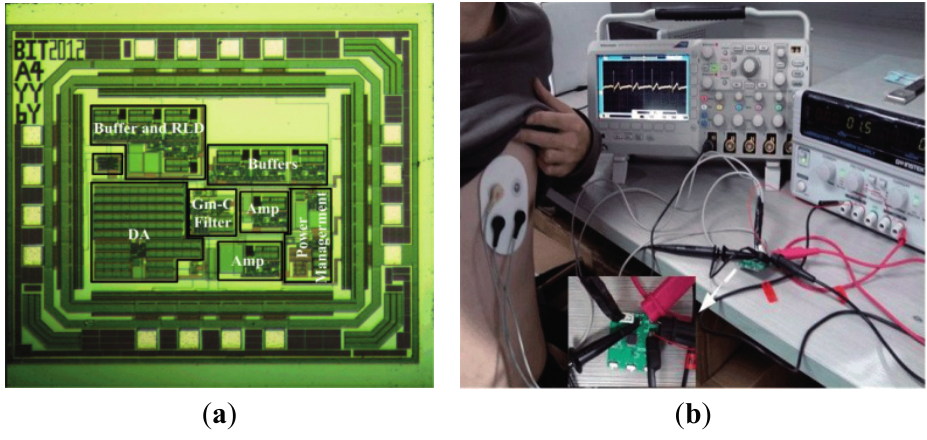
Figure 6. ( a ) The micro photograph; ( b ) Experiment of proposed AFE in ECG Acquisition